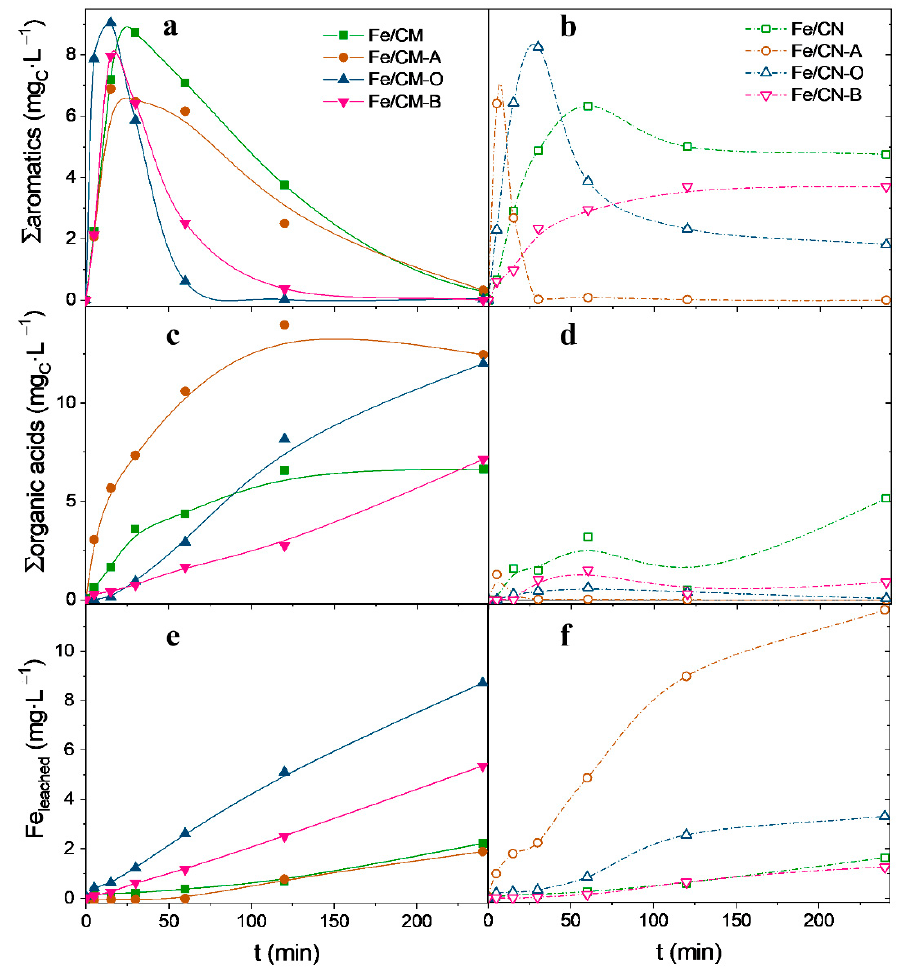
Figure 5. Evolution of CWPO intermediates along reaction time: Aromatics on ( a ) Fe/CM- f catalysts, and ( b ) Fe/CN- f catalysts. Short-chain organic acids on ( c ) Fe/CM- f catalysts and ( d ) Fe/CN- f catalysts. Iron leachate on: ( e ) Fe/CM- f catalysts and ( f ) Fe/CN- f catalysts. Reaction conditions: 50 mL reaction volume, 100 mg·L − 1 phenol, 500 mg·L − 1 catalyst, 500 mg·L − 1 H 2 O 2 , pH 3, 200 rpm, 50°C.